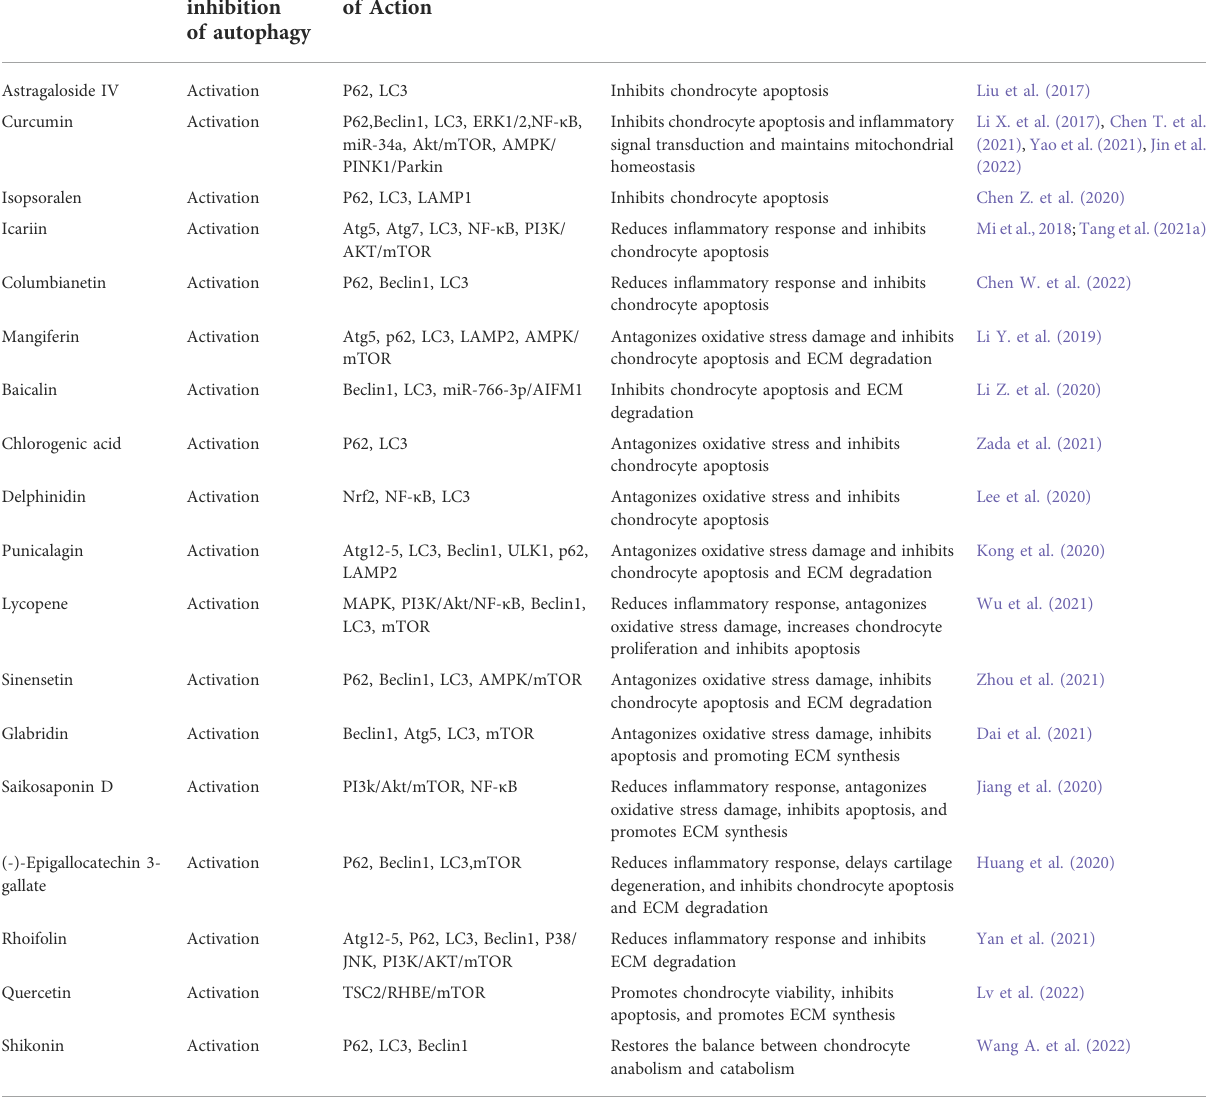
TABLE 3 Natural products for the treatment of OA by targeting